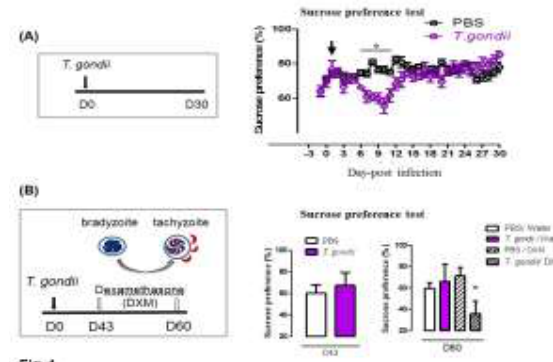
Fig. 1: Reduced sucrose preference following T. gondii infection. (A) Reduced sucrose preference, a hall mark of anhedonic behavior, was calculated as the percentage of total fluid intake over 24 hours for 1 month after T. gondii infection or PBS injection ( n = 8). (B) In T. gondii- infected or PBS-injected mice, dexamethasone (DXM) was continuously administered in drinking water from 43 to 58 dpi. Sucrose preference was measured in 2 groups before DXM treatment at 42 dpi ( n = 12) and in 4 groups after DXM treatment at 60 dpi ( n = 6). * indicate significant differences between PBS-injected and T. gondii- infected groups and data represent mean ±